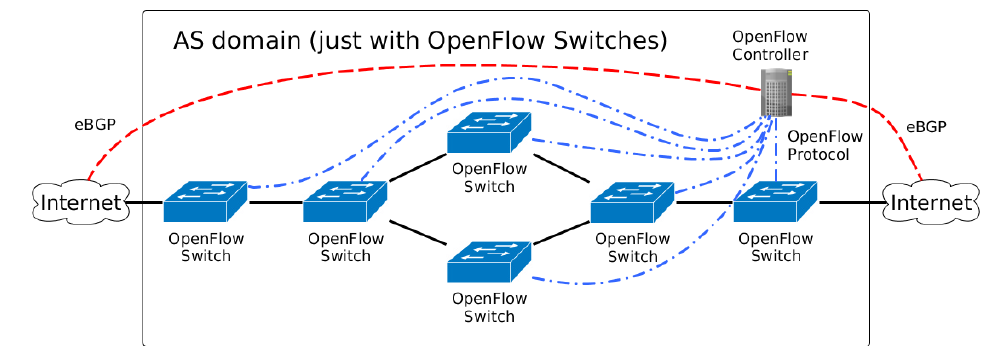
Figure 2. AS domain composed of only OpenFlow switches.